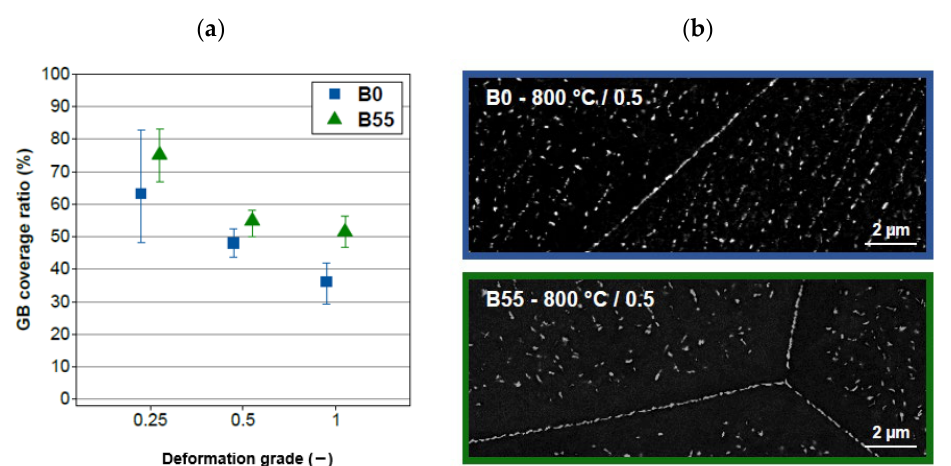
Figure 7. ( a ) Grain boundary coverage ratio (Laves phase precipitates occupied grain boundary length relative to the total length) after thermomechanical treatment with varying deformation grades of 0.25/0.5/1 at an 800 °C deformation temperature. ( b ) SEM-BSE precipitation images (800 °C with 0.5 deformation grade).